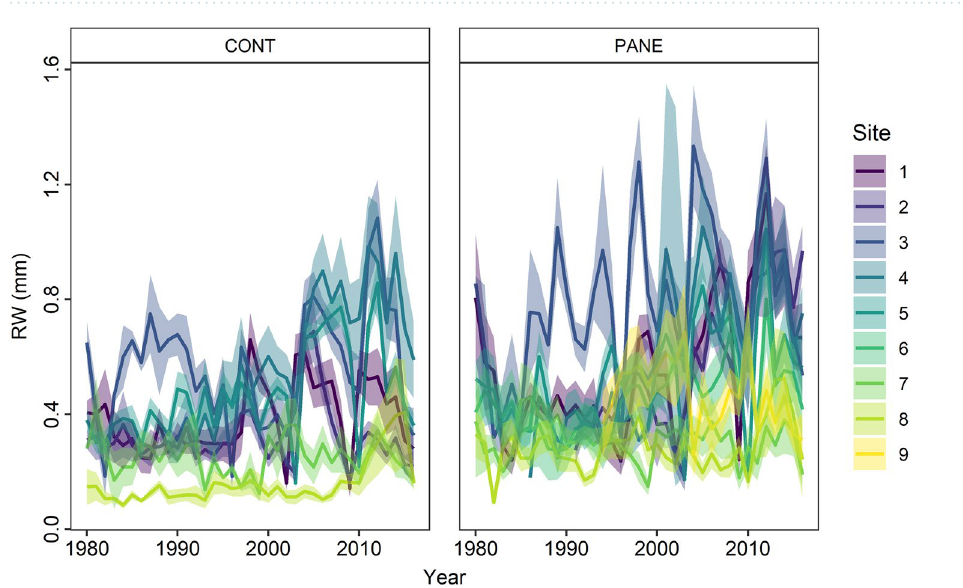
Figure 3. Time series of ring width (mm) of Salix glauca L. from nine sites along the Nuuk Fjord (Southwest Greenland). Samples refer to control (CONT) and past anthropogenic nutrient enrichment (PANE) soils. Data are means ± SE. Colours refer to the ice to sea